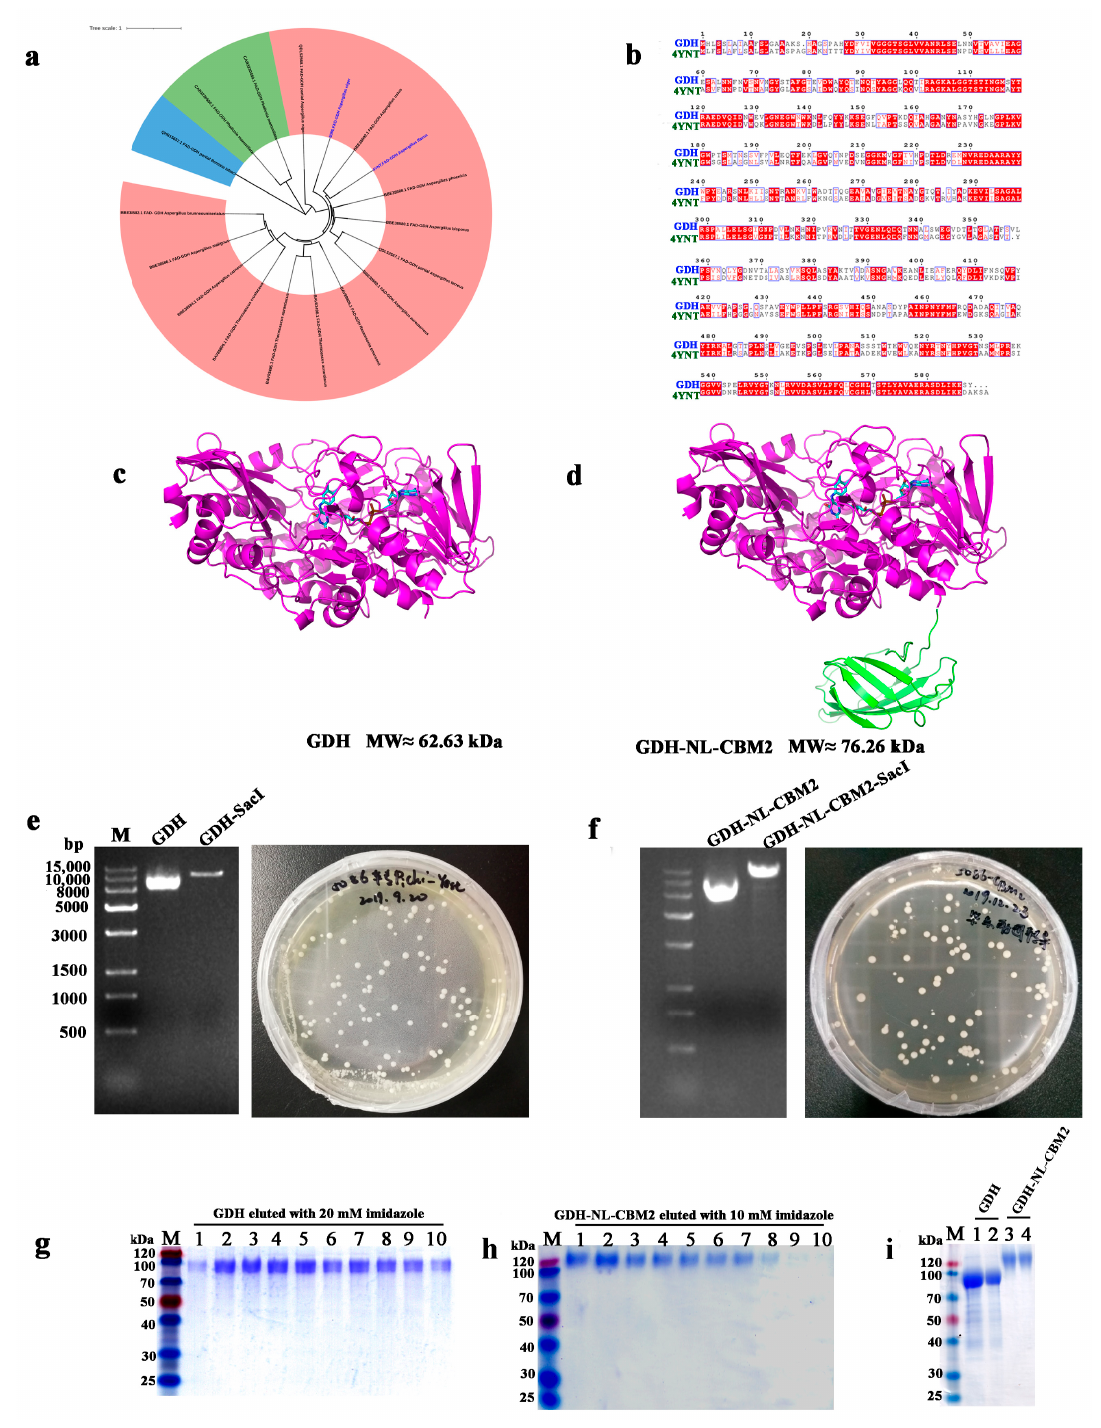
Figure 1. Sequence, phylogenetic, and structural analysis of FAD-GDH from A. niger An76 as well as SDS-PAGE analysis of heterologously expressed FAD-GDH proteins. ( a ) Phylogenetic analysis of the fFAD-GDHs retrieved from the CAZy database; ( b ) Sequence alignments of Aspergillus flavus FAD-GDH (AfGDH, PDB ID: 4YNT); ( c , d ) Predicted structures of wild-type GDH and fusion GDH (GDH-NL-CBM2), respectively; ( e , f ) Agarose gel electrophoresis analysis of the original and linearized plasmids of pPIC9k-GDH and pPIC9k-GDH-NL-CBM2, respectively; ( g ) Lane M: protein standard marker, Lanes 1–10: the eluting numerical sequence under the optimal imidazole elution concentrations of GDH and GDH-NL-CBM2, SDS-PAGE of GDH eluted with 20 mM imidazole; ( h ) SDS-PAGE of GDH-NL-CBM2 eluted with 10 mM imidazole; ( i ) SDS-PAGE of concentrated GDH and GDH-NL-CBM2, lanes 1 and 2, 3, and 4 were duplicate tests for GDH and GDH-NL-CBM2,